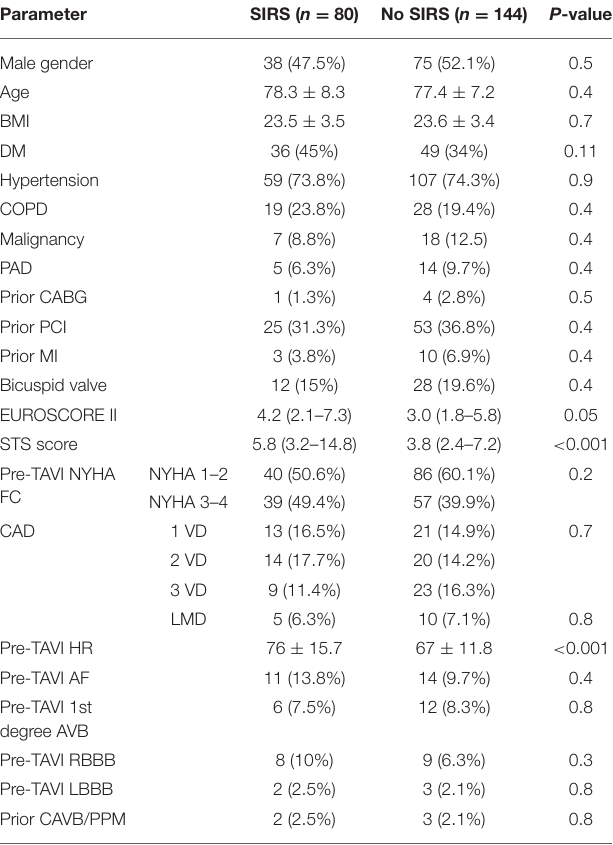
TABLE 1 | Baseline clinical parameters.